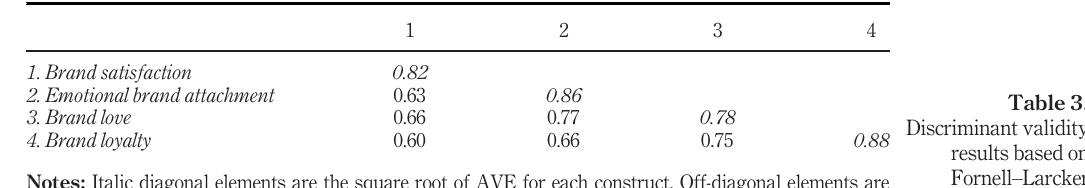
Table 2. Validity and